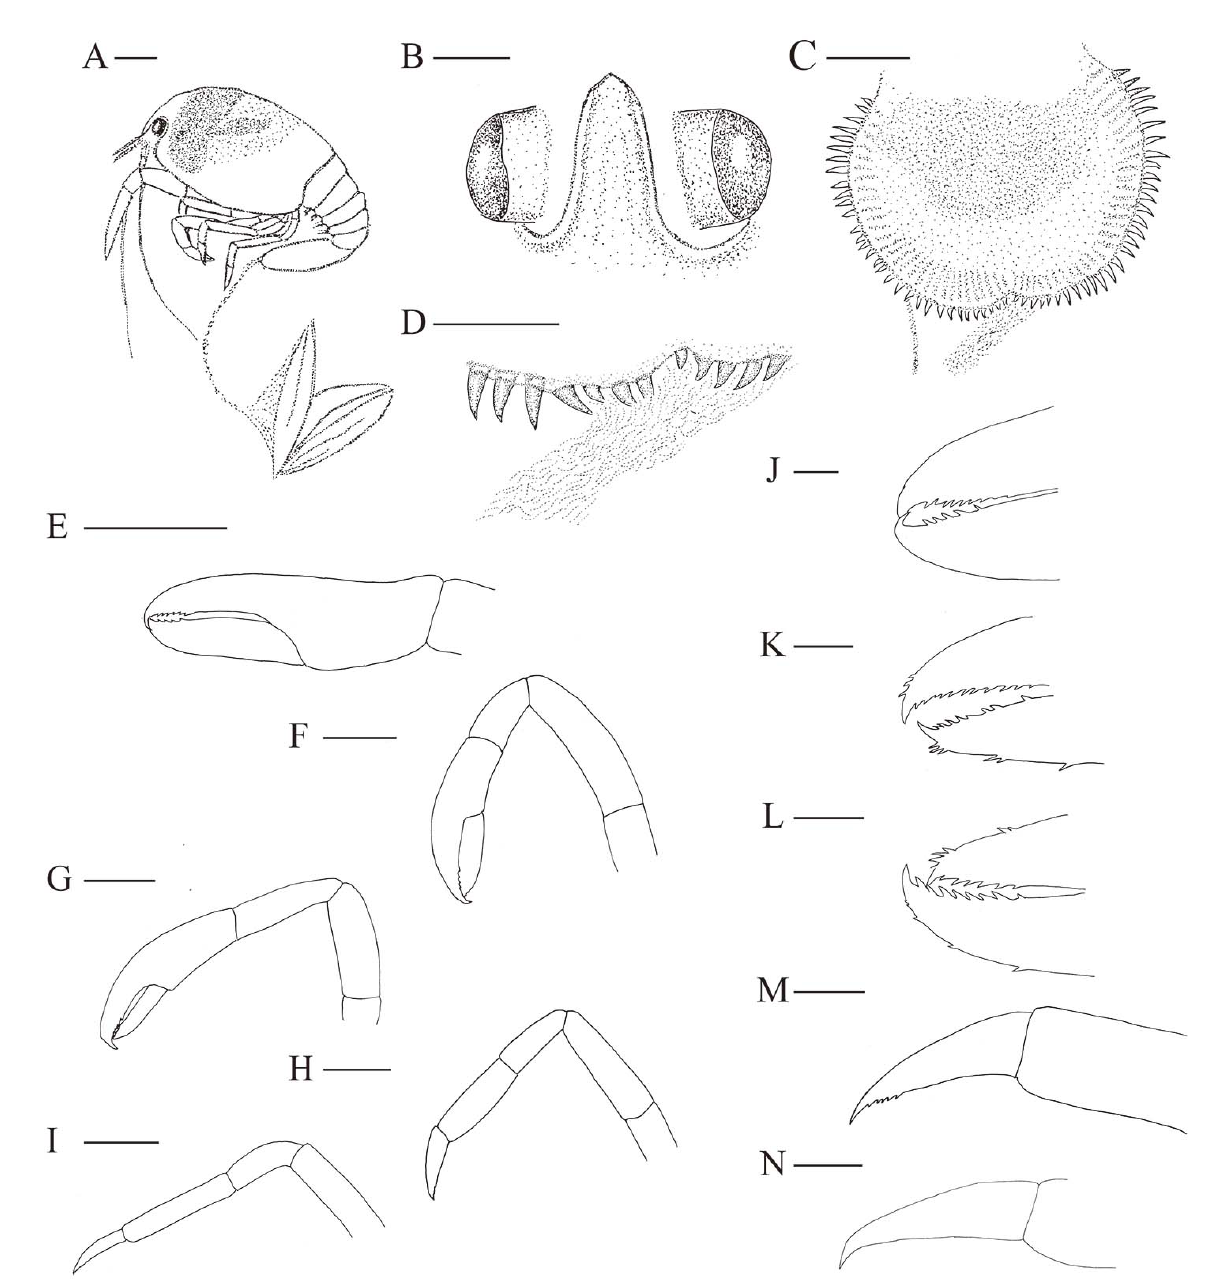
Figure 13. Juvenile Stage I of Cambaroides japonicus . ( A ) Habitus, lateral view; ( B ) eyes and rostrum, dorsal view; ( C ) tail fan and telson thread, dorsal view; ( D ) posterior edge of the telson and telson thread; ( E–I ), pereiopods 1–5, dorsal or lateral view; ( J–N ) distal segments of pereiopods 1–5, dorsal or lateral view. Scale bars: 0.25